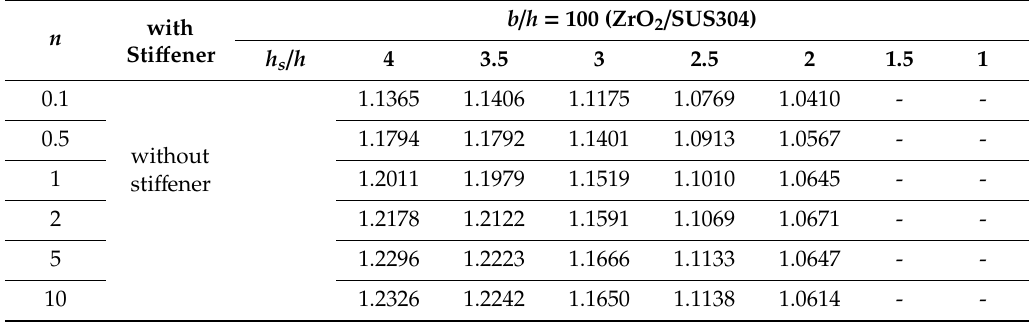
Table 12. The mass reduction between ZrO 2 / SUS304 plate with and without a central sti ff ener ( b / h =